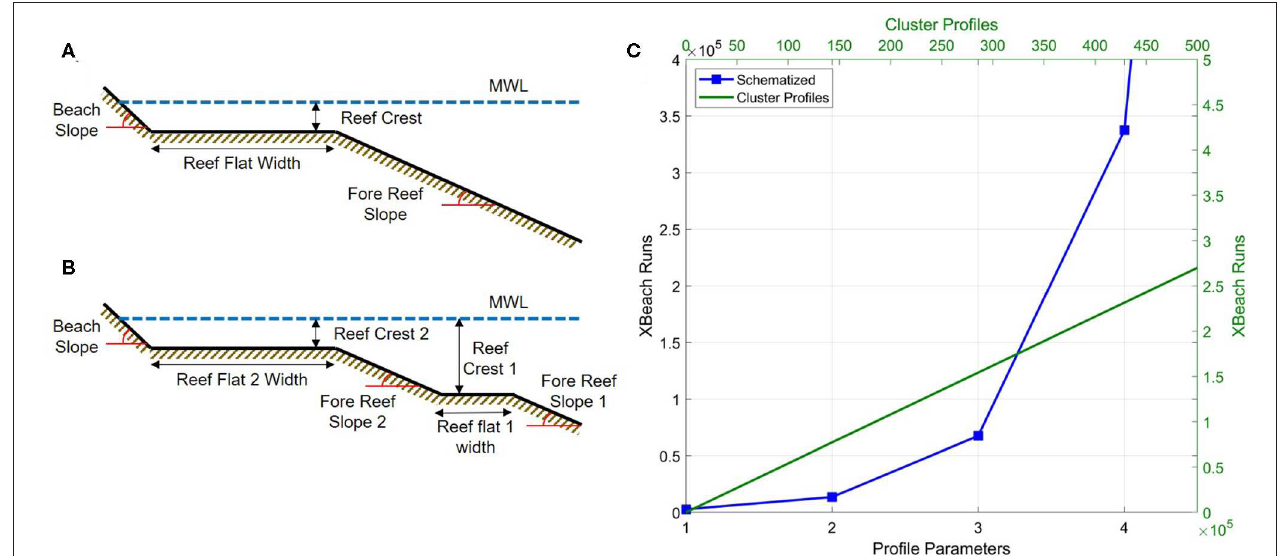
FIGURE 12 | The required number of XBeach Non-Hydrostatic (XBNH) runs (C) for different numbers of representative cluster profiles (RCPs) (top and right axis) or a schematized profile (bottom and left axis) such as that of BEWARE, assuming 540 XBNH runs are needed per profile (Pearson et al., 2017). (A) An example of a schematized profile with four parameters and (B) how three more parameters are required to be added to the schematized profile in order to represent a second reef flat, corresponding to the x-axis in (C)